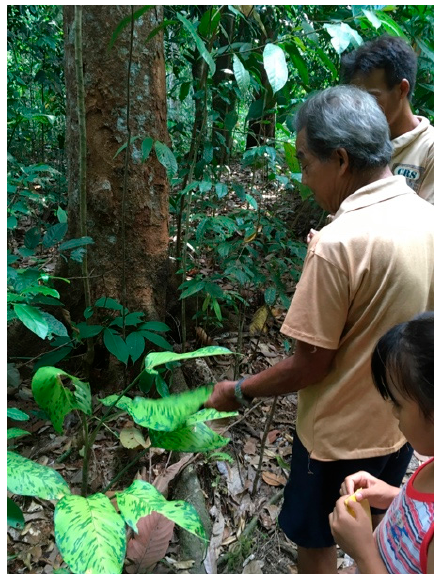
Figure 5. Adat elder showing ceremonial plants found in the adat forest.